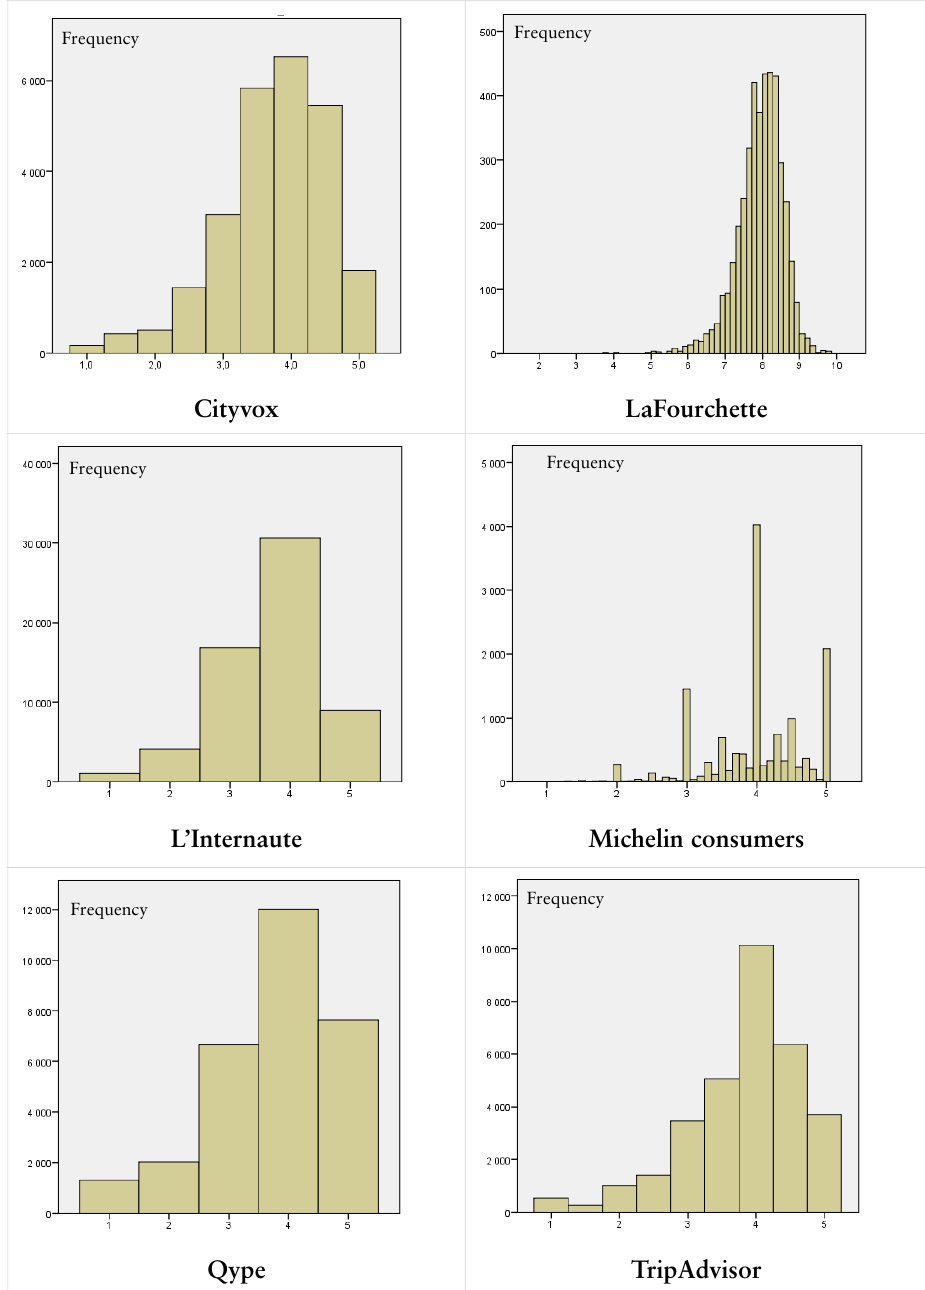
Figure 1. Distribution of average scores of restaurants.